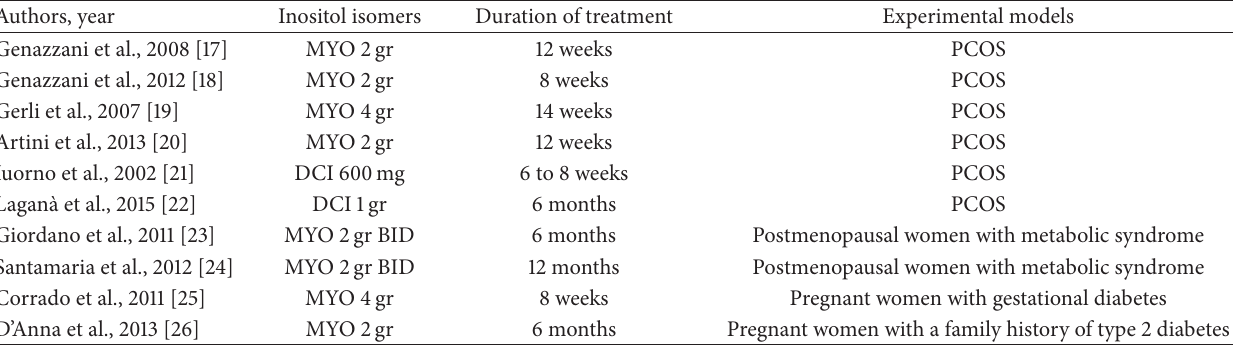
Table 1: Clinical studies in which MYO or DCI supplementation has been evaluated for the treatment of disease associated to insulin